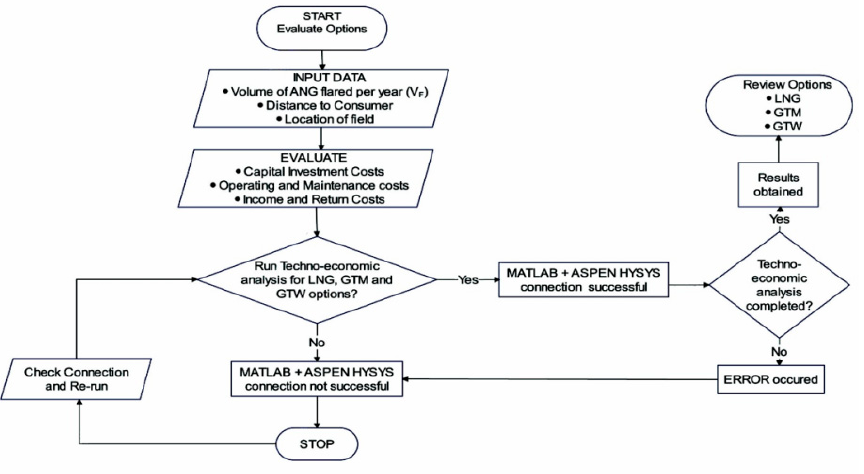
Figure 10. Evaluate Options flowchart.